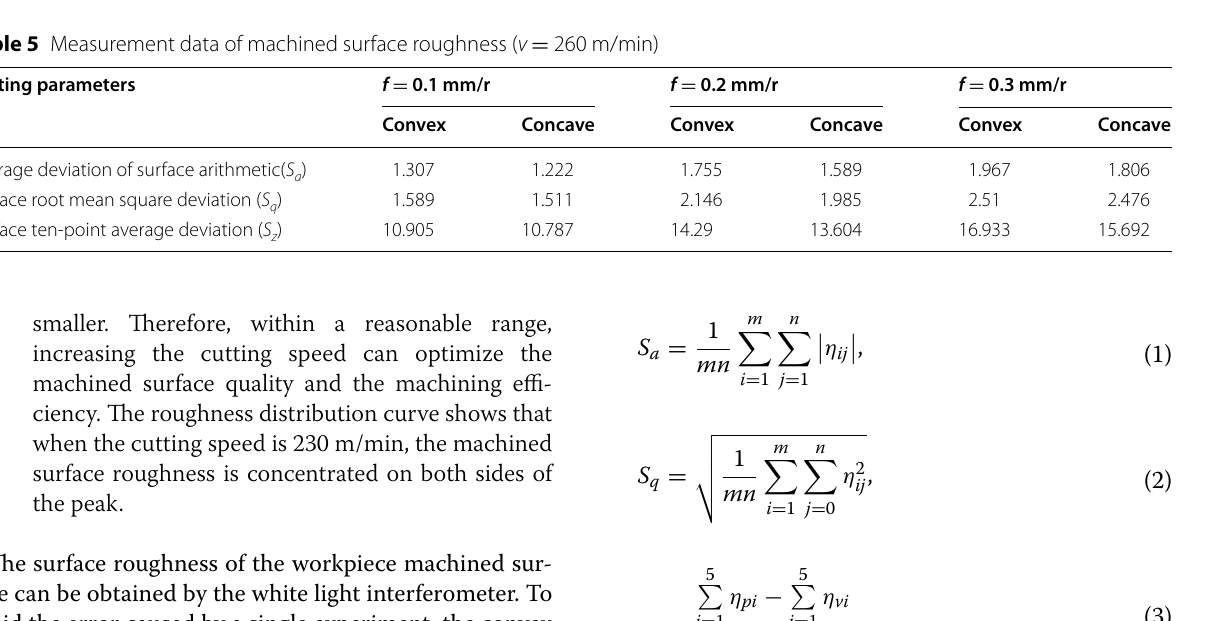
Table 4 Measurement data of machined surface roughness ( f Cutting parameters v Average deviation of surface arithmetic ( S a ) Surface root mean square deviation ( S q ) Surface ten-point average deviation ( S z )